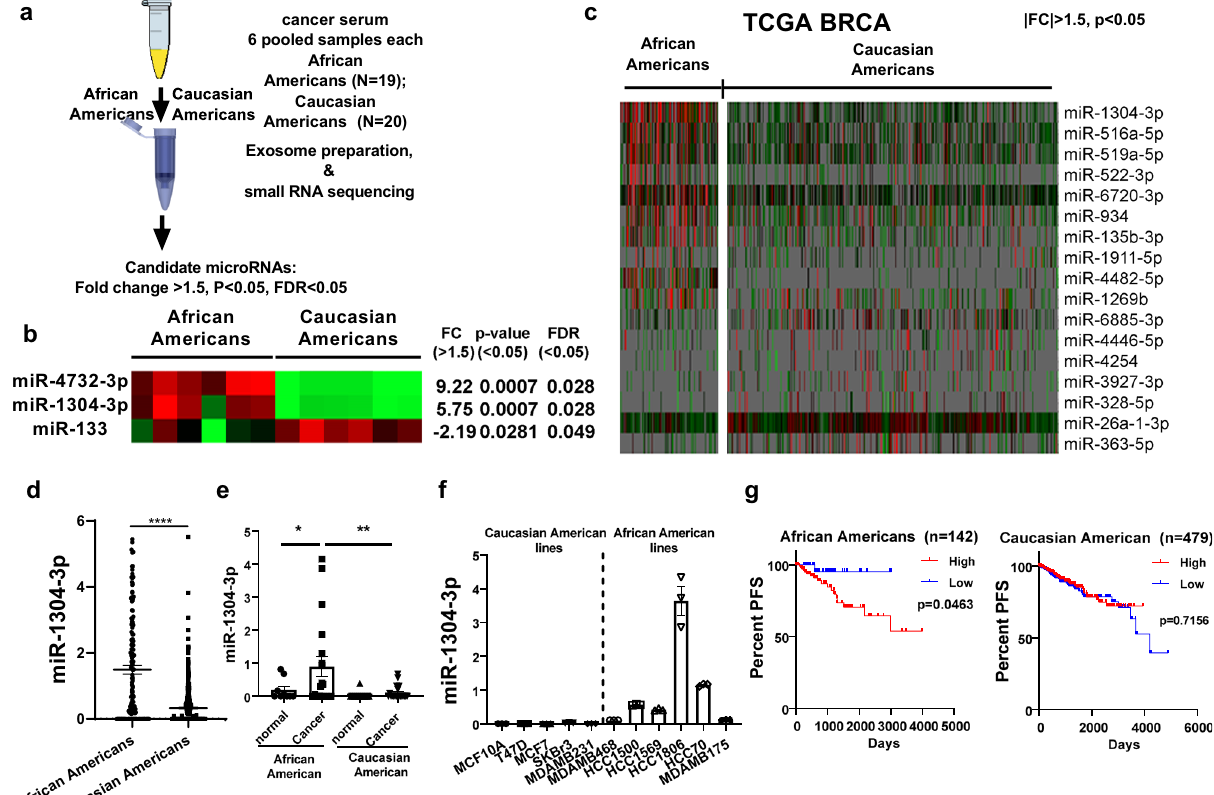
Fig. 1 | miR-1304-3p is elevated in African American breast cancer. a Scheme of experimentalprocedure.SixpooledserumsampleseachfromAfricanAmericanor CaucasianAmericanbreastcancerpatients(eachconsistedof3or4patientsserum mixed with equal volume) were used for exosome extraction and then RNA extraction. Small RNA sequencing was performed. Candidate microRNAs were selected based on fold change >1.5, p value and FDR <0.05. b Heatmap showing signi fi cantly differentially expressed microRNAs in serum exosomes between AfricanAmericansandCaucasianAmericanfromRNAsequencingdata.Thep-value and FDRwerecalculated with r package DESeq2. c Heatmap showing differentially expressed microRNAs between African Americans ( n = 142) and Caucasian Amer- icans ( n = 479). MicroRNA expression data (log2(RPM+1)) for the TCGA-BRCA cohort were obtained from Xenabrowser. Unpaired two-sided student t-test was performed to calculate the p value. For the listed genes p < 0.05, fold change>1.5. d RelativemiR-1304-3pexpression(log2(RPM+1))inAfricanAmericanorCaucasian AmericanpatientsfromTCGA-BRCAcohort. n =142forAfricanAmericansand479 for Caucasian Americans. Unpaired two sided student t-test was performed,